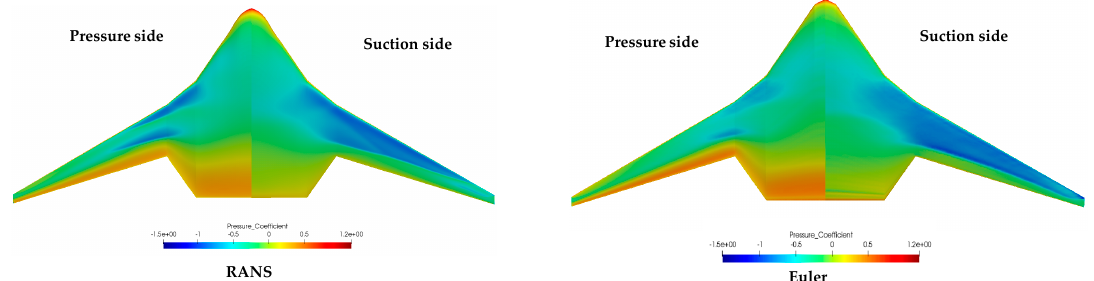
Figure A16. Pressure coefficients for RANS and Euler simulations at AoA = 1 deg.